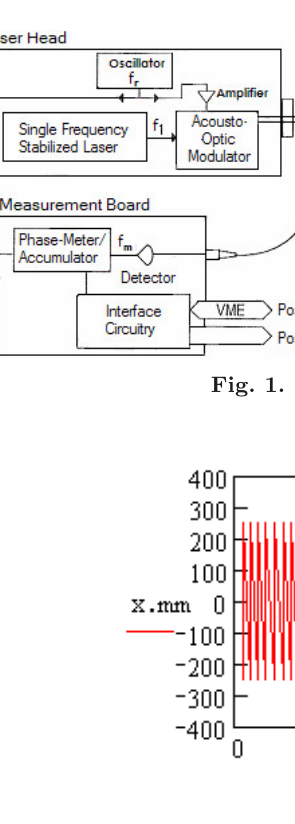
Fig. 2. Stepping linear displacement 500 mm over 100 sec incremental